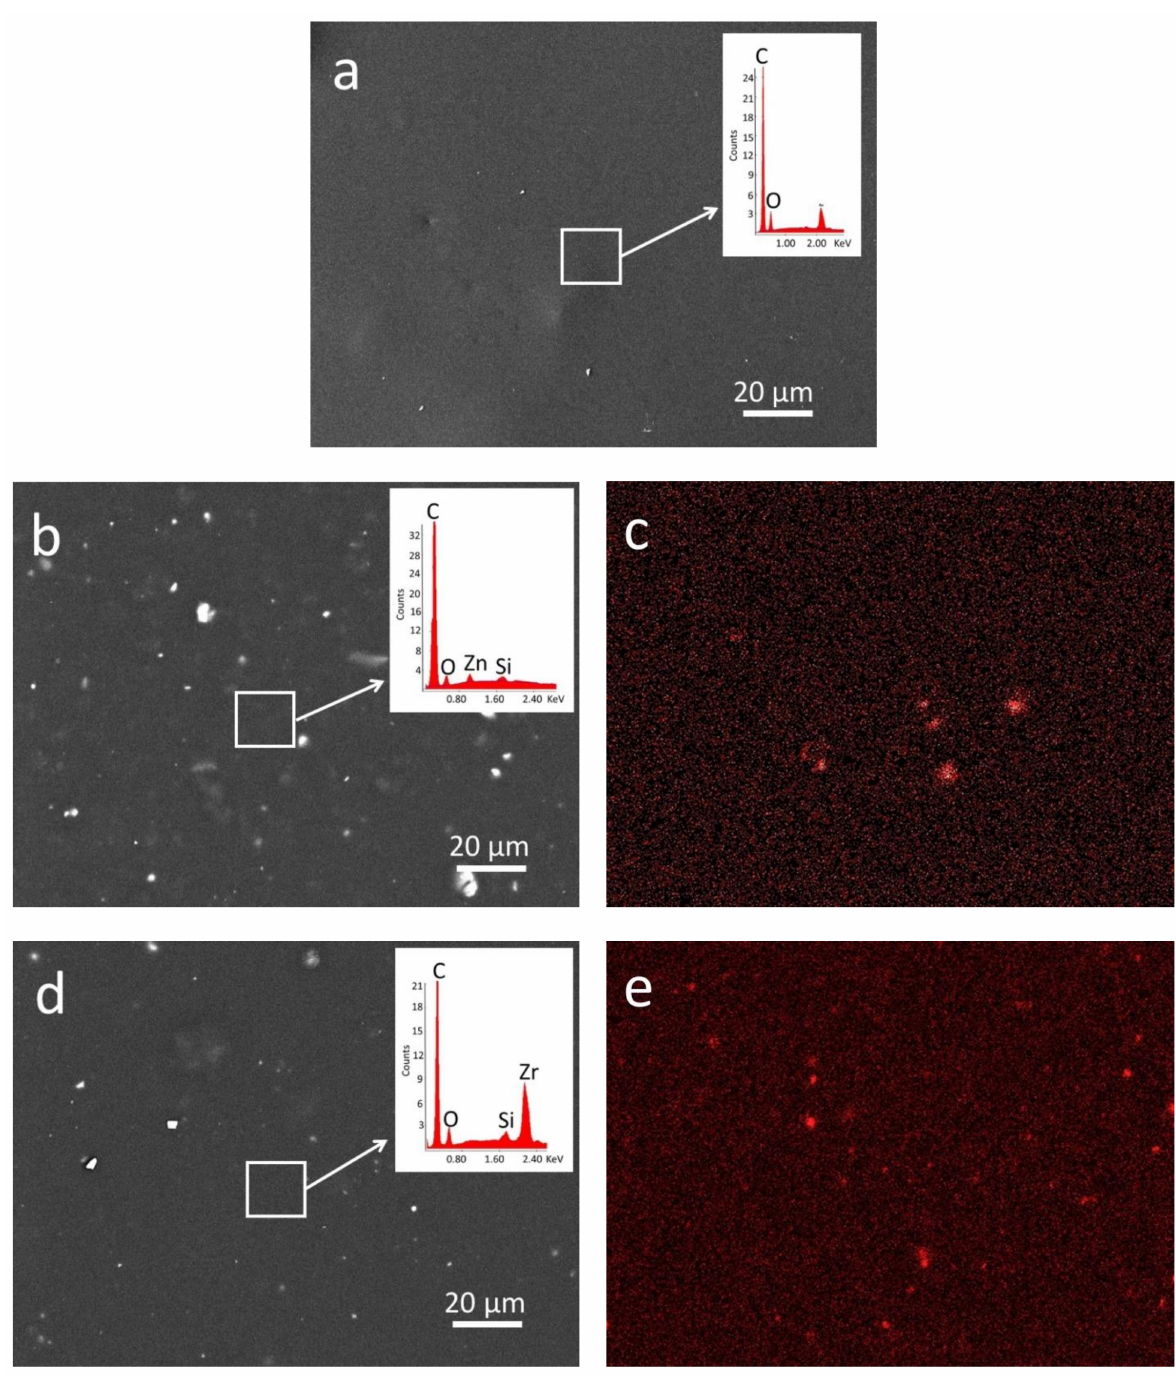
Figure 5. SEM micrographs of treated wood specimens: ( a ) SH; ( b ) ZnO-ES-SH and ( c ) the corresponding energy-dispersive X-ray spectroscopy (EDS) elemental mapping of zinc; ( d ) ZrO 2 -ES-SH and ( e ) the corresponding EDS elemental mapping of zirconium. Selected EDS spectra are shown in the insets of SEM images. Au peaks (2.1–2.2 KeV) in the spectra are due to gold sputtering of the samples. High concentrations of Zn or Zr (and of the corresponding nanoparticles) are represented by red spots in the